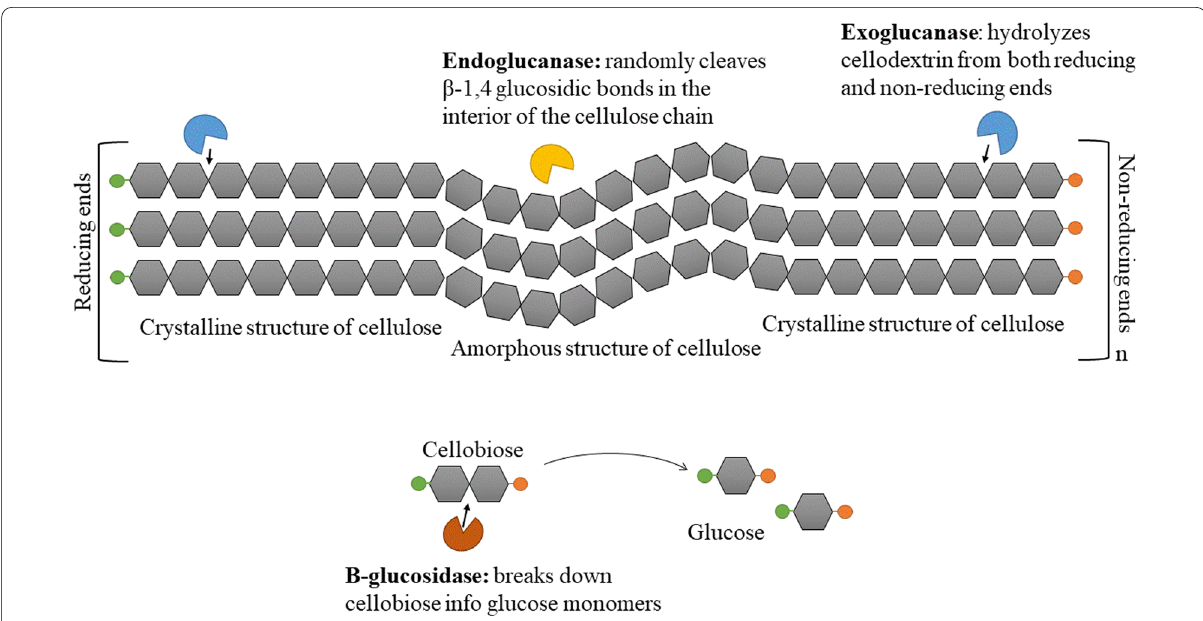
Fig. 1 Action mechanism of cellulolytic enzymes: endoglucanase randomly cleaves internal bonds at amorphous sites that create new chain ends; exoglucanase cleaves two to four units from the ends of the exposed chains produced by endocellulase, resulting in disaccharides, such as cellobiose; and β-glucosidase hydrolyses disaccharides into individual monosaccharides, such as